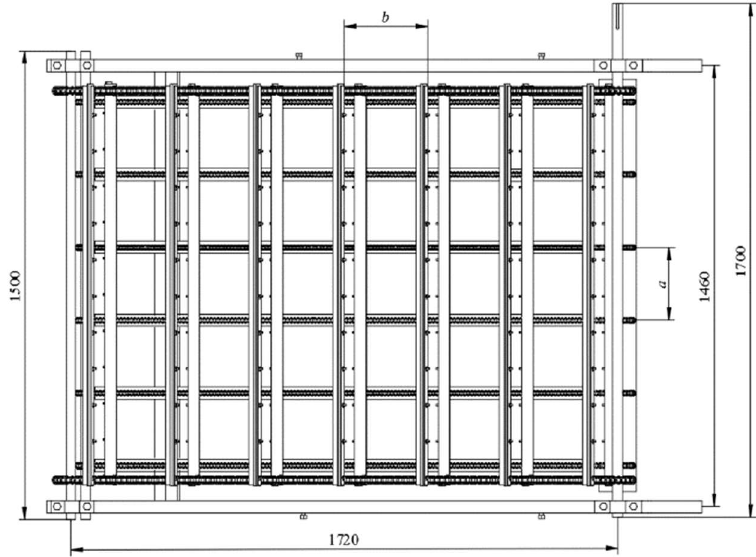
Figure 3. Top view. a = the spacing between two adjacent residual film conveying chains; b = the spacing between two adjacent clamp plates.